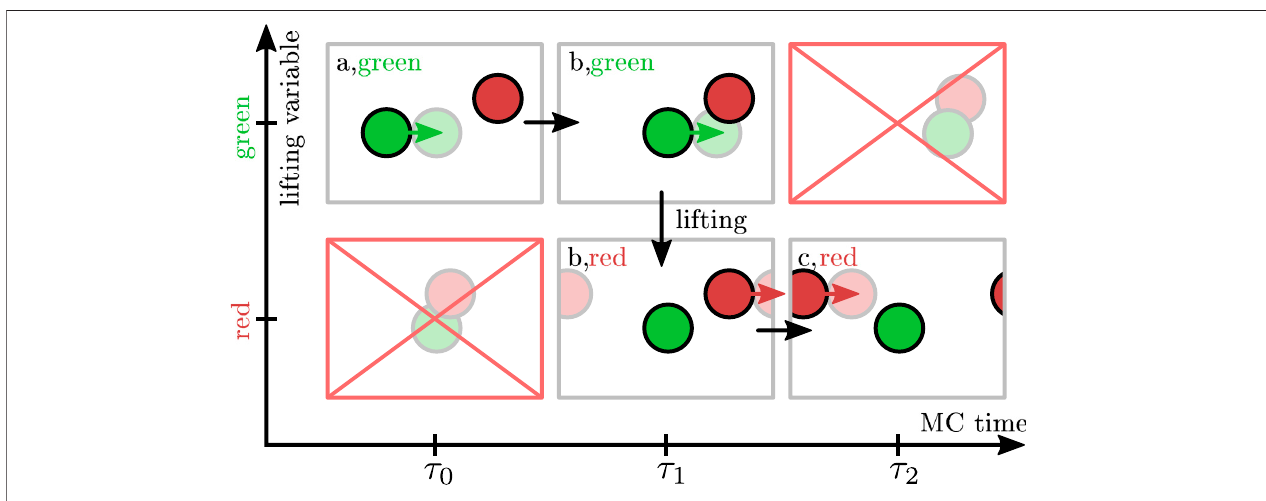
FIGURE 2 | Scheme of the lifting formalism for hard spheres. The physical states are labeled with letters (a,b,c) and the lifting variable is indicated by color, i.e., the current active particle is indicated by a colored arrow. The EC displacement direction is to the right. Proposed in fi nitesimal displacements are indicated by opaque spheres. In case of a physical rejection at MC step τ 1 the pivot particle is changed and rejection is avoided. Periodic boundaries ensure ergodicity. One way to read this scheme, is that the lower row is the displacement-reversed version (except trivial translations) of the upper row (obtained be reversing all displacements dw → − dw ), resulting in a central symmetry, especially ( c ,red) (cid:2) ( a ,green).